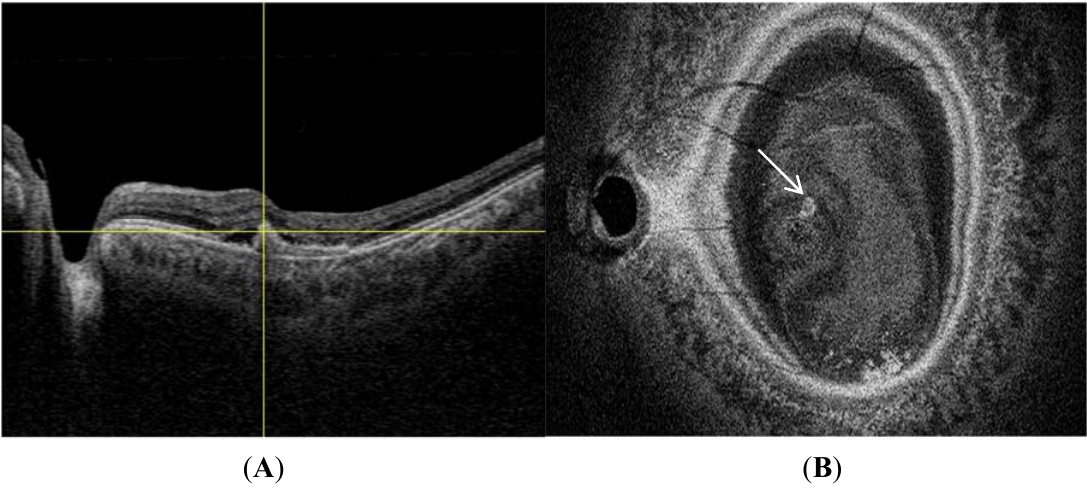
Figure 5. Enface swept source optical coherence tomography (OCT) image ( B ) shows the position of a polyp (white arrow) that corresponds in location to the polyp (intersection of yellow lines) seen on swept source B, scan image ( A